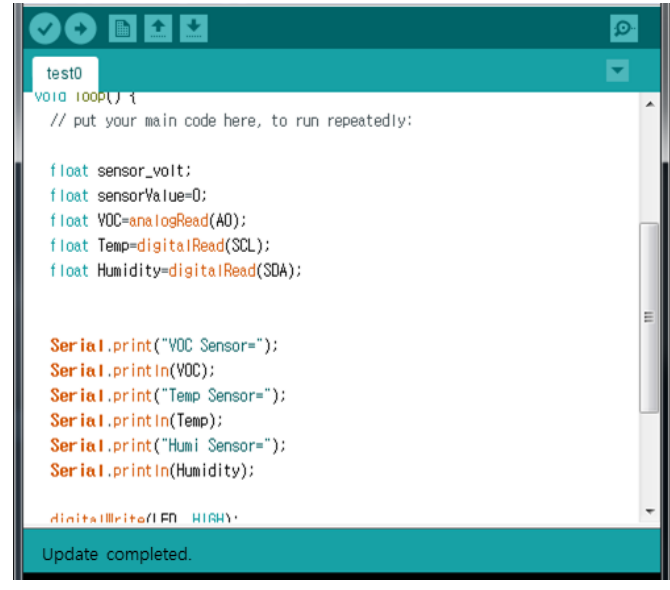
Figure 13. The Arduino used in the system implementation.